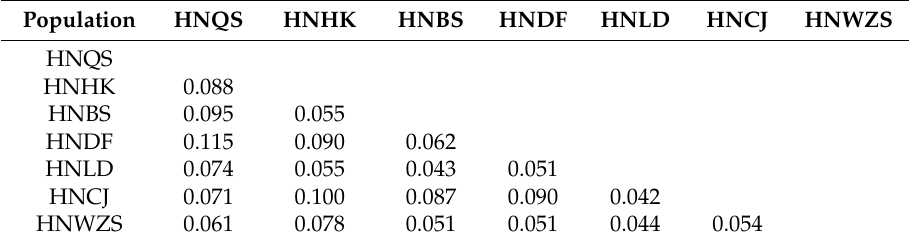
Table 6. Pairwise Genetic Differentiation Index (F st ) between the seven